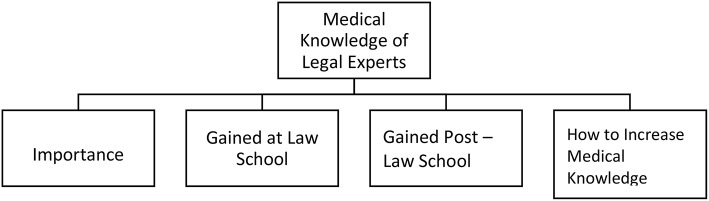
Main categories.